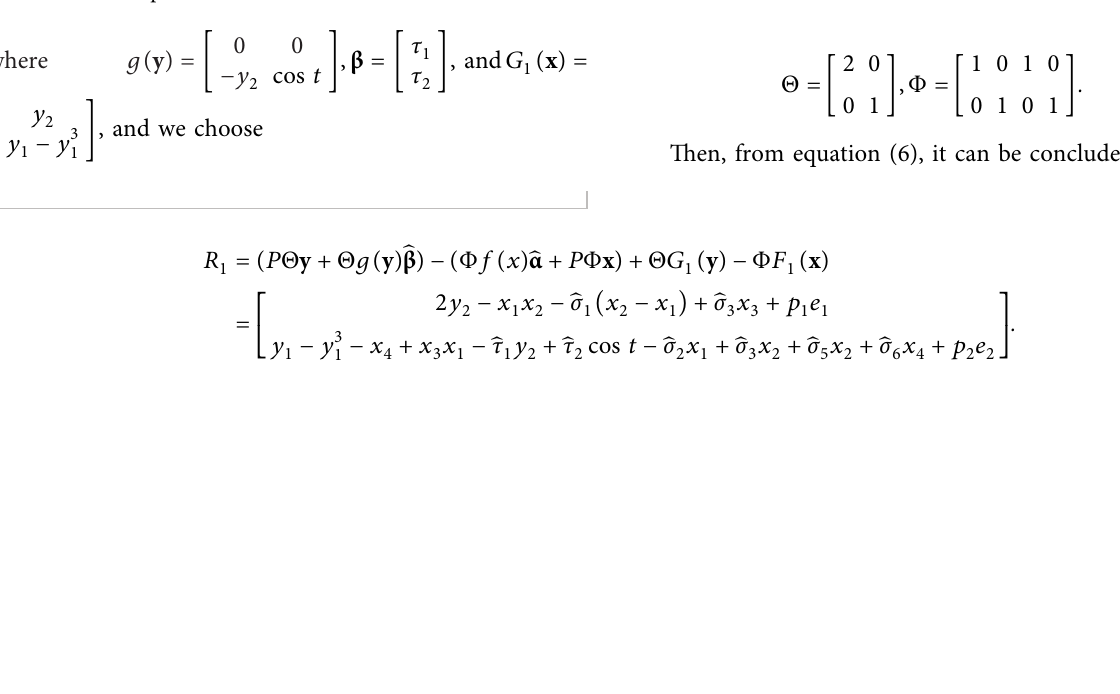
Figure 3: (a) Trajectories of the errors; (b) trajectories of the drive system unknown parameter estimates; (c) trajectories of the response system unknown parameter